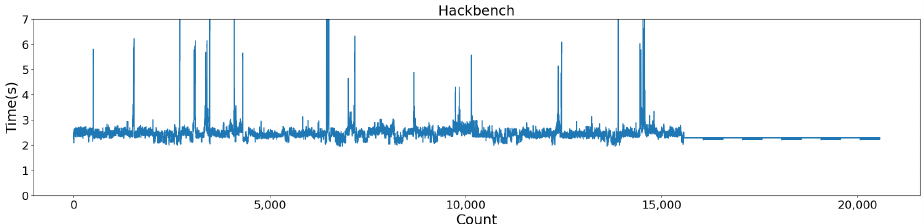
Figure 6. Change in Hackbench performance time in the STUN learning process, where the x-axis is the number of runs and the y-axis is the time of Hackbench.